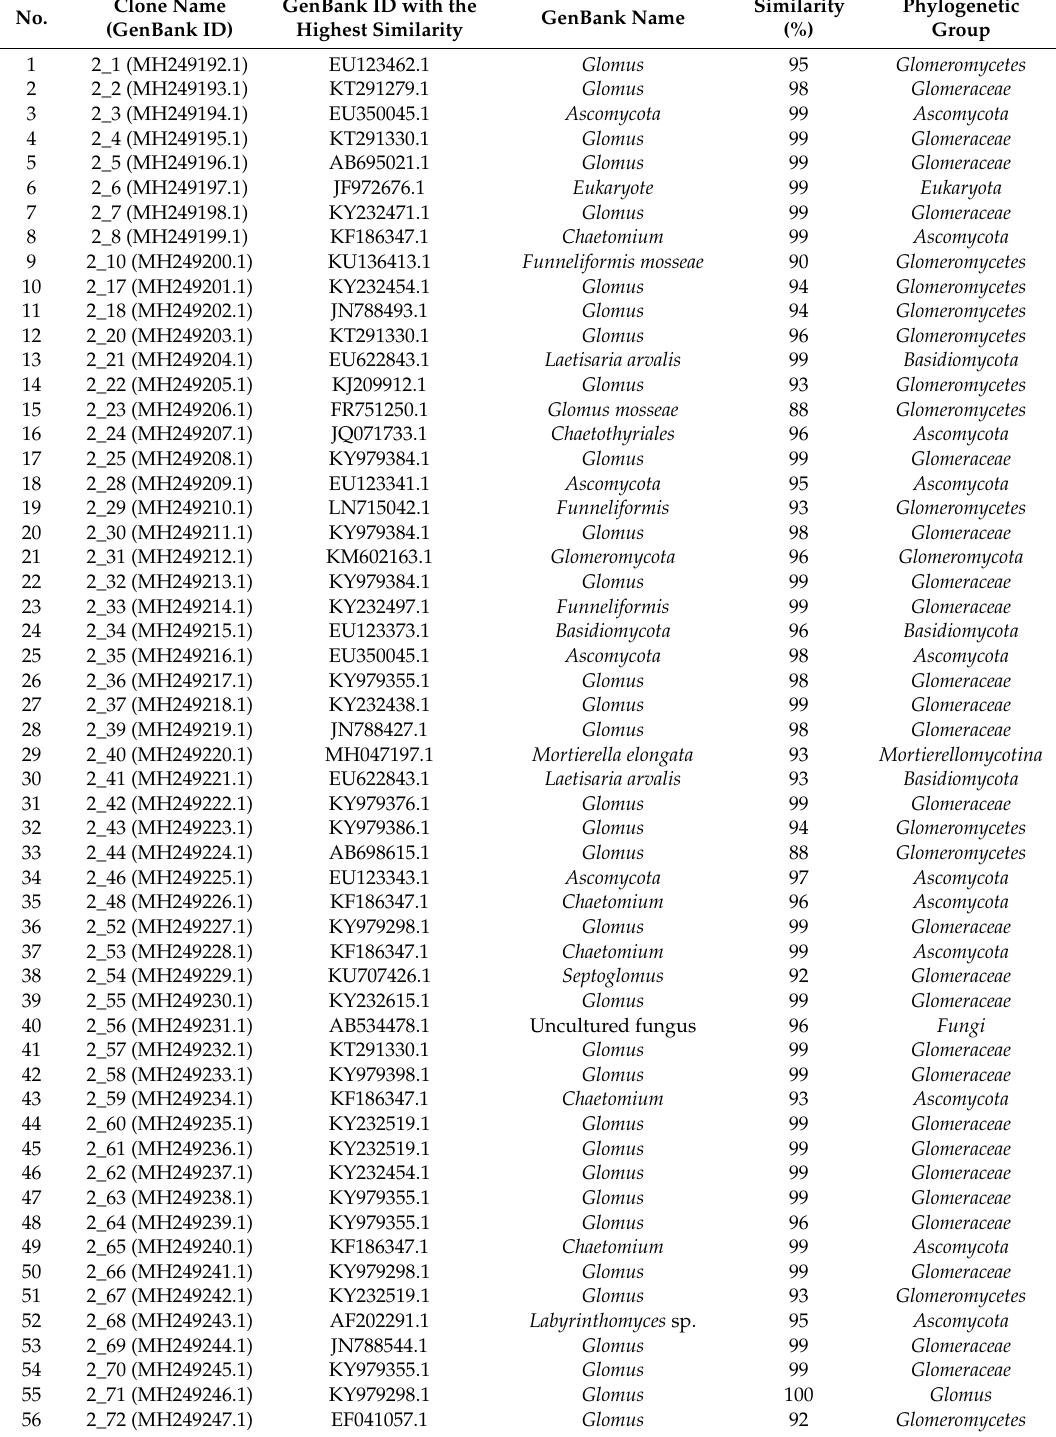
Table 5. Comparison of sequenced clones from the rhizosphere of Arundo donax with 15 t / ha of SS in the soil with 18S rDNA sequences of fungi with the highest similarity using Nucleotide